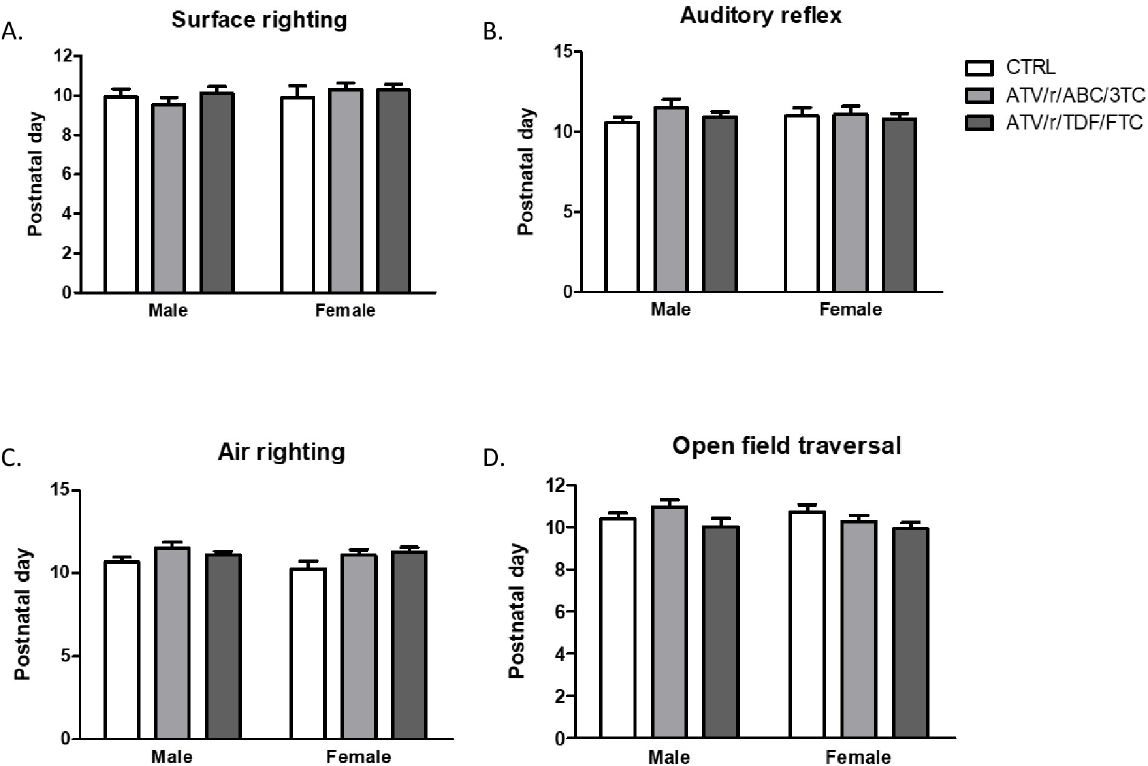
Fig 5. In-utero exposure to ART does not disrupt the development of every primitive reflex. Postnatal day of successful acquisition of surface righting reflex (A), auditory reflex (B), air righting reflex (C), and open field traversal (D) for male and female pups exposed in-utero to control (CTRL, white bars), ATV/r/ABC/3TC (light grey bars), or ATV/r/TDF/FTC (dark grey bars). Data are mean ± SEM (n = 11–34 pups/group). A mixed effects model was used to examine differences between control and treatment arms (fixed effect) accounting for litter effects (random effect) stratified by sex. No statistically significant differences were observed. ATV/r, ritonavir-boosted atazanavir; ABC, abacavir; 3TC, lamivudine; TDF, tenofovir; FTC, emtricitabine; CTRL,